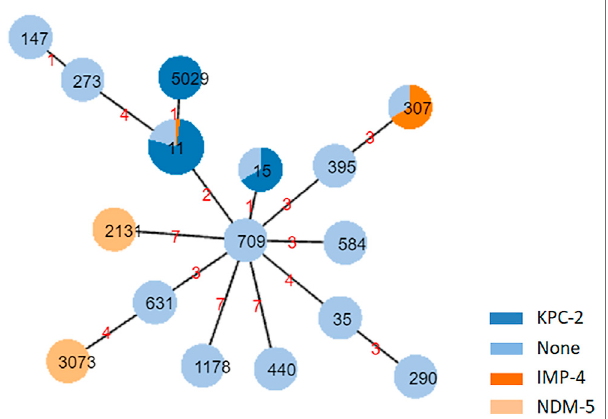
FIGURE 1 | eBURST diagrams of Klebsiella pneumoniae isolates showing the relationship among isolates on the basis of their multilocus sequence typing and carbapenemase. Each node withinthetreerepresentsa single ST. The size of the nodes is proportional to the number of isolates represented by the said node. Within each node, the area of dark blue, dark orange, light orange, and light blue represents the number of KPC-2, IMP-4, NDM-5 and no carbapenemase. Nodes are labeled with corresponding ST. ST, sequence type. Links are labeled with absolute distance.